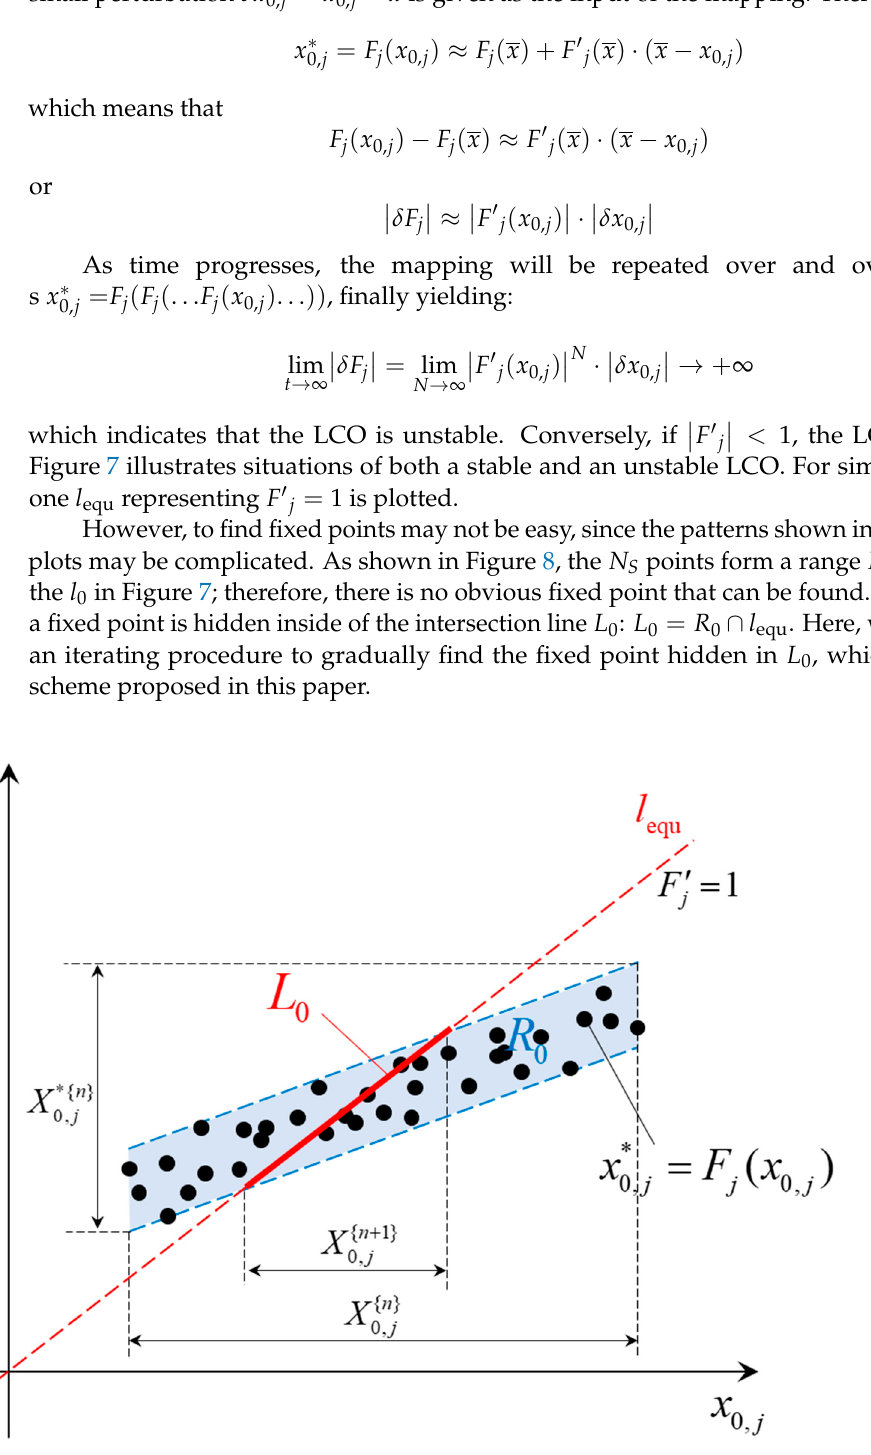
Figure 8. Illustration of the j -th iteration plot, where the spatial pattern indicates the occurrence of an LCO but the effects of transient phases and noises are also taken into consideration, so that the distributing region of all points is a belt region R 0 rather than a line, as shown in Figure 3.